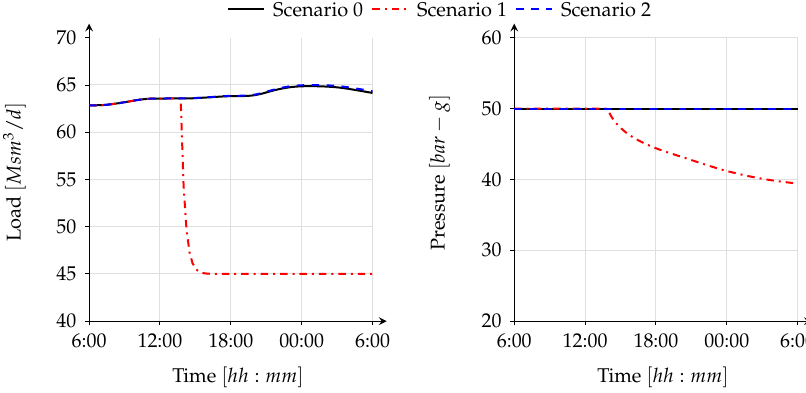
Figure 8. Time evolution of gas supply and pressure at the cross border import (CBI) node for the computed scenarios